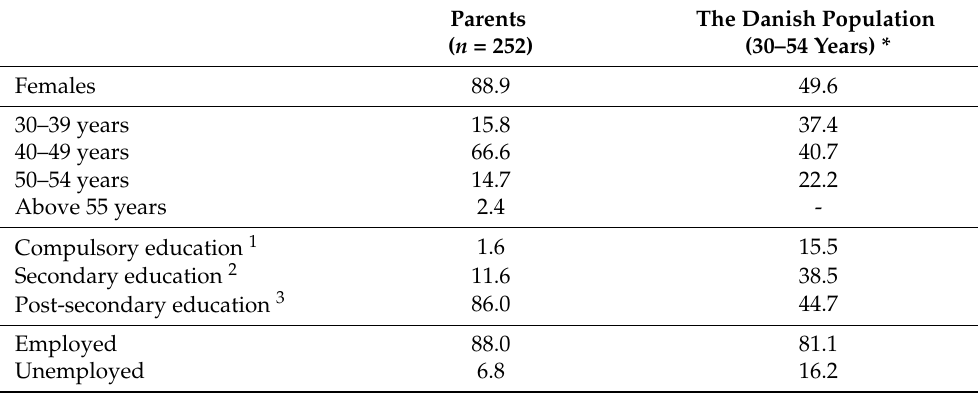
Table 1. Characteristics of the study population (parents of schoolchildren with type 1 diabetes) and the background population (the Danish population 30–54 years of age). Characteristics are presented in frequencies (%). For extended description, see Appendix A, Table A1.